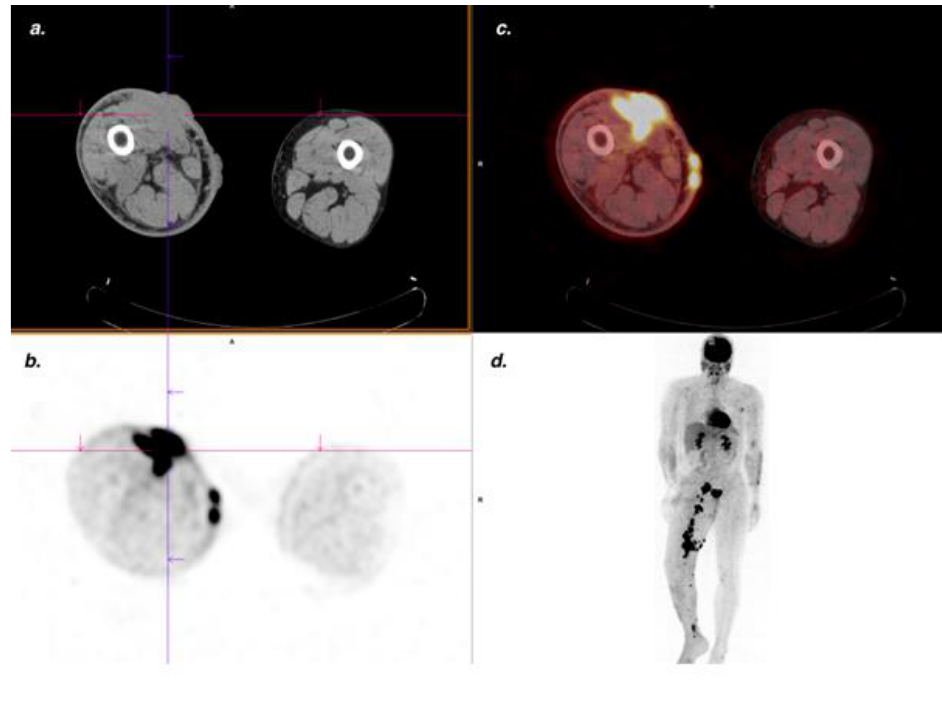
Figure 3. Classic KS. FDG PET/CT identifying hypermetabolic (SUVmax = 4.7) involvement of calcaneum contiguous to cutaneous and subcutaneous lesions. ( a ) Sagittal CT slice; ( b ) Sagittal-fused PET/CT slice.